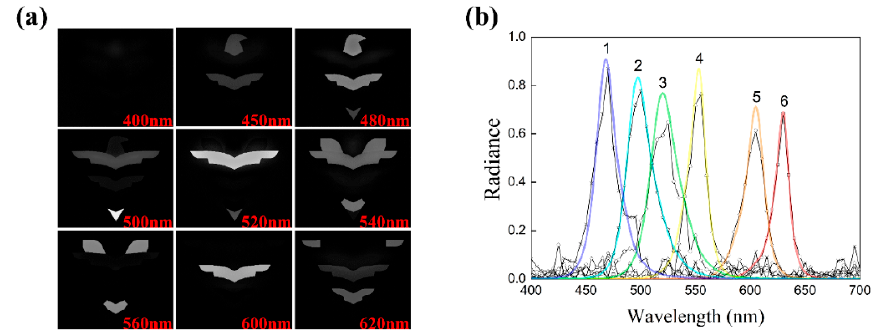
Figure 6. Spectral image restoration and spectral discrimination of the six-color ZJU logo target. ( a ) Different wavelength bands of restored images of the ZJU logo target. ( b ) Comparison of the restored (5 nm resolution) and target (continuous) ROIs spectra corresponding to ROI numbers 1–6 in Figure 3c.